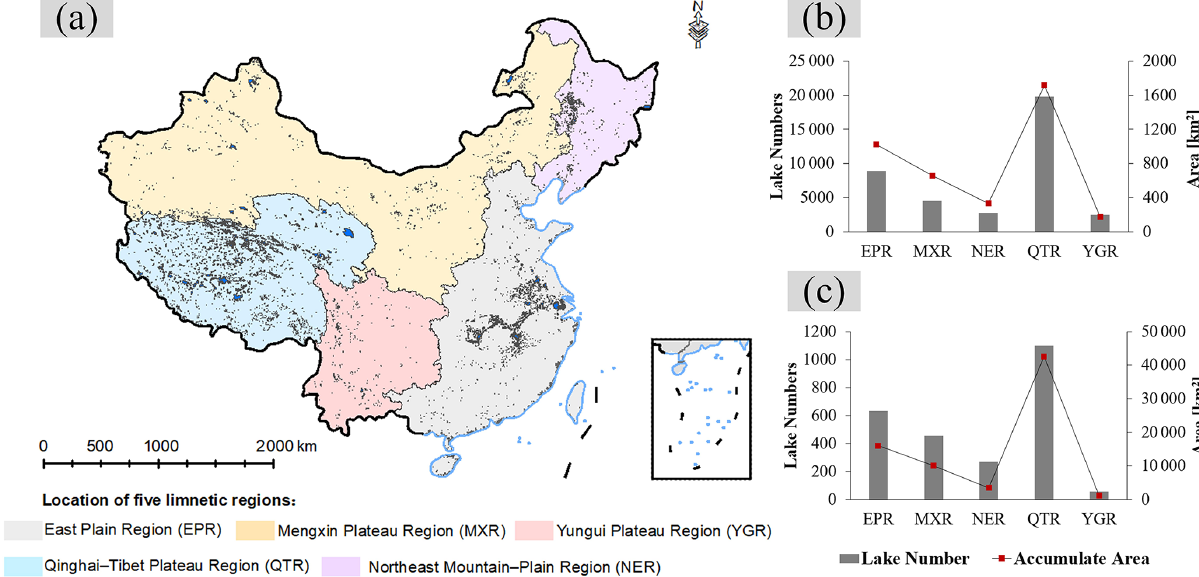
Figure 9. The location of the five limnetic regions and the lake statistics in each limnetic region. (a) The location of the five limnetic regions, (b) statistics of lakes with areas ≤ 1km 2 in each region, and (c) statistics of lakes with areas > 1km 2 in each region. The location of the five limnetic regions comes from Ma et al. (2011) and Chen et al.